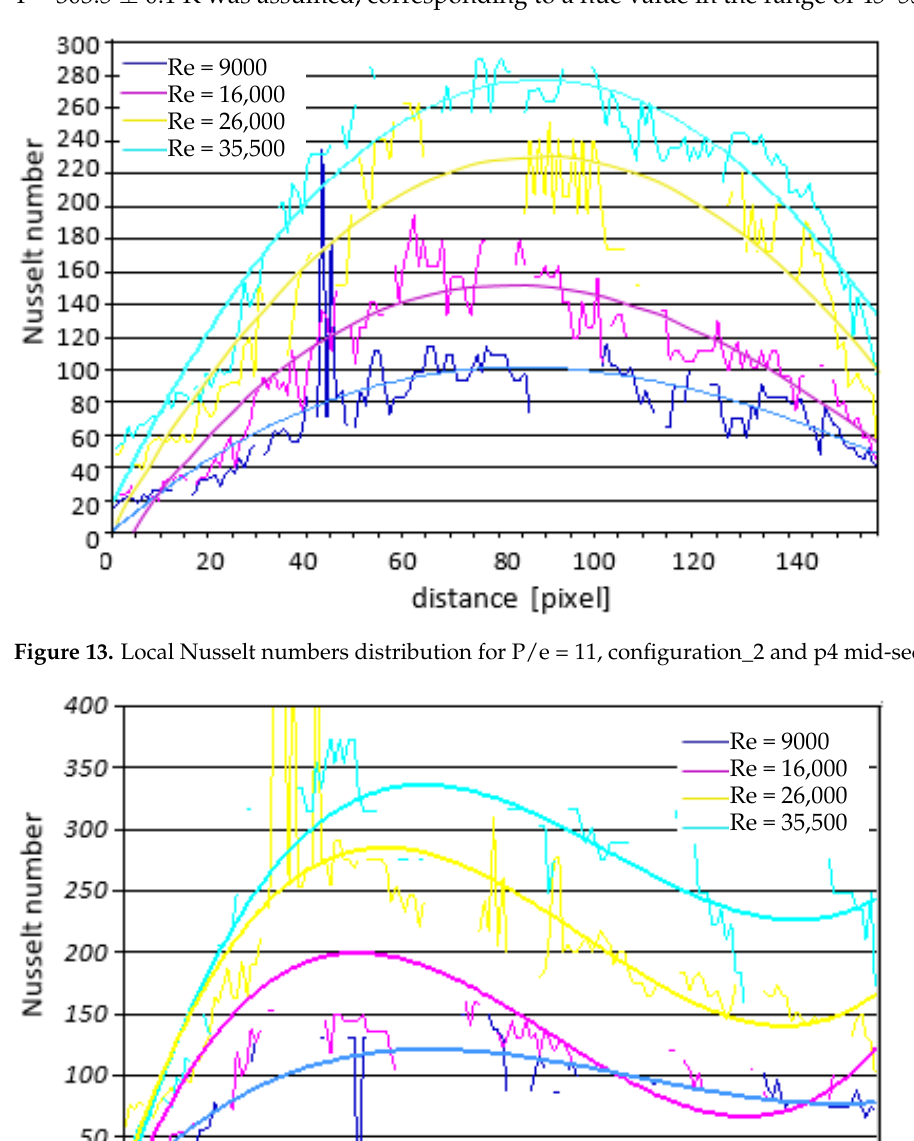
Figure 15. Local Nusselt numbers distribution for P/e = 11, configuration¬_4 and p4 mid-section.